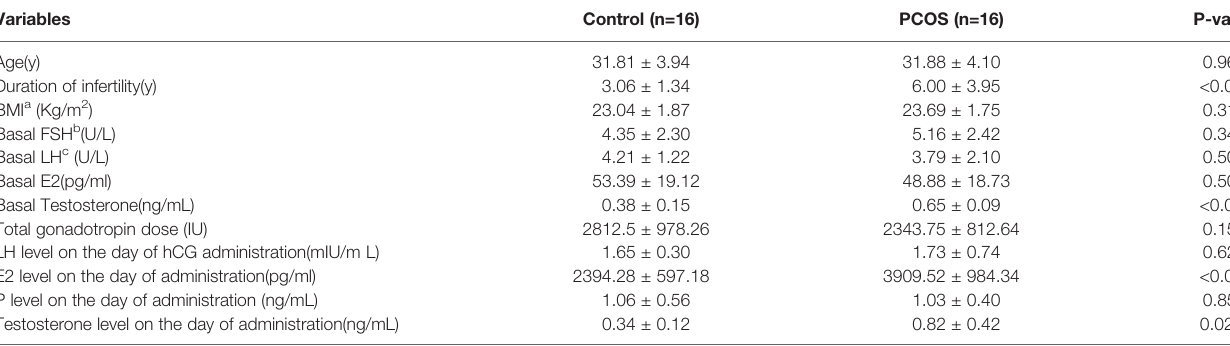
TABLE 3 | Clinical characteristics of the study participants between control and PCOS group X ± S. Variables